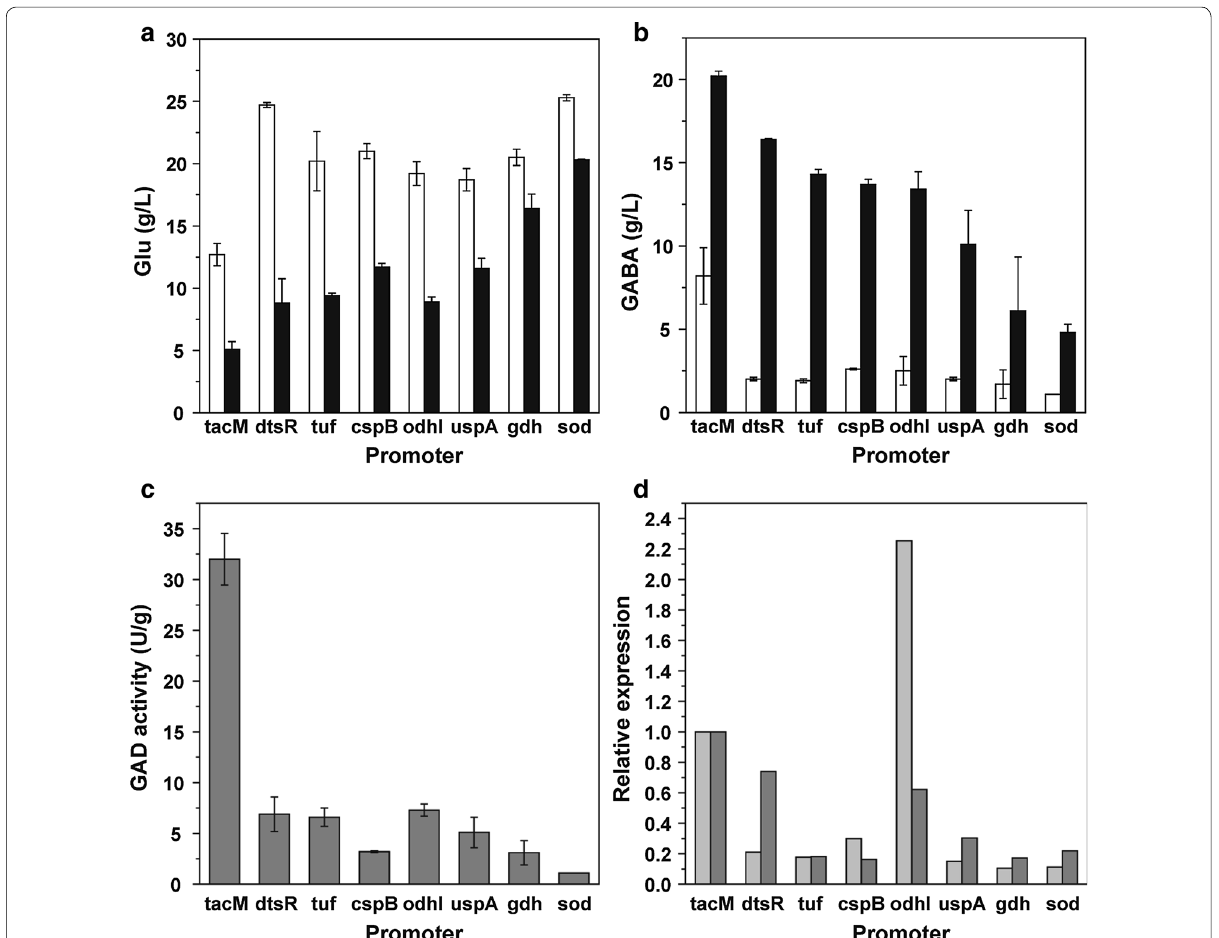
Fig. 3 GABA production and expression level of gadB2 -expressing C. glutamicum strains controlled by some constitutive promoters. a Glu concen- tration, b GABA concentration, c GAD activity, d gadB2 transcription level. White bars at 36 h, black bars at 72 h, grey bars at 20 h, dark grey bars at 40 h. Each point represents the average of three independent